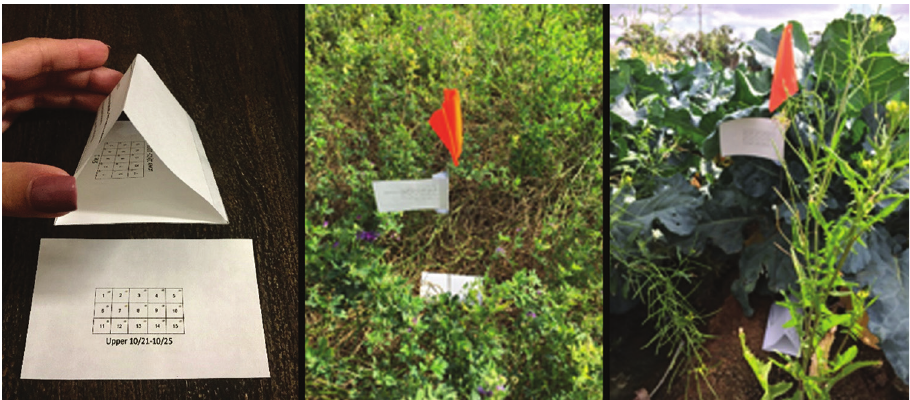
Figure 3. From left to right: The triangular and flat sentinel cards used in the study; the cards attached to a landscape flag wire in an alfalfa field; and in a vegetable field with broccoli and wild